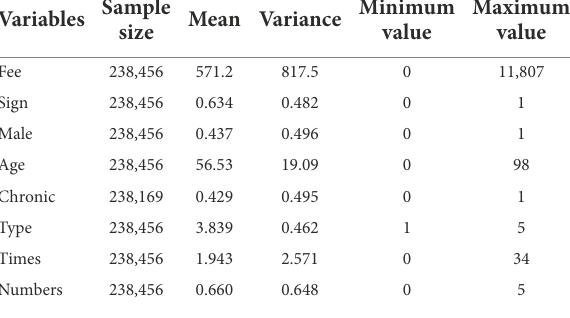
TABLE 2 The descriptive statistics of main